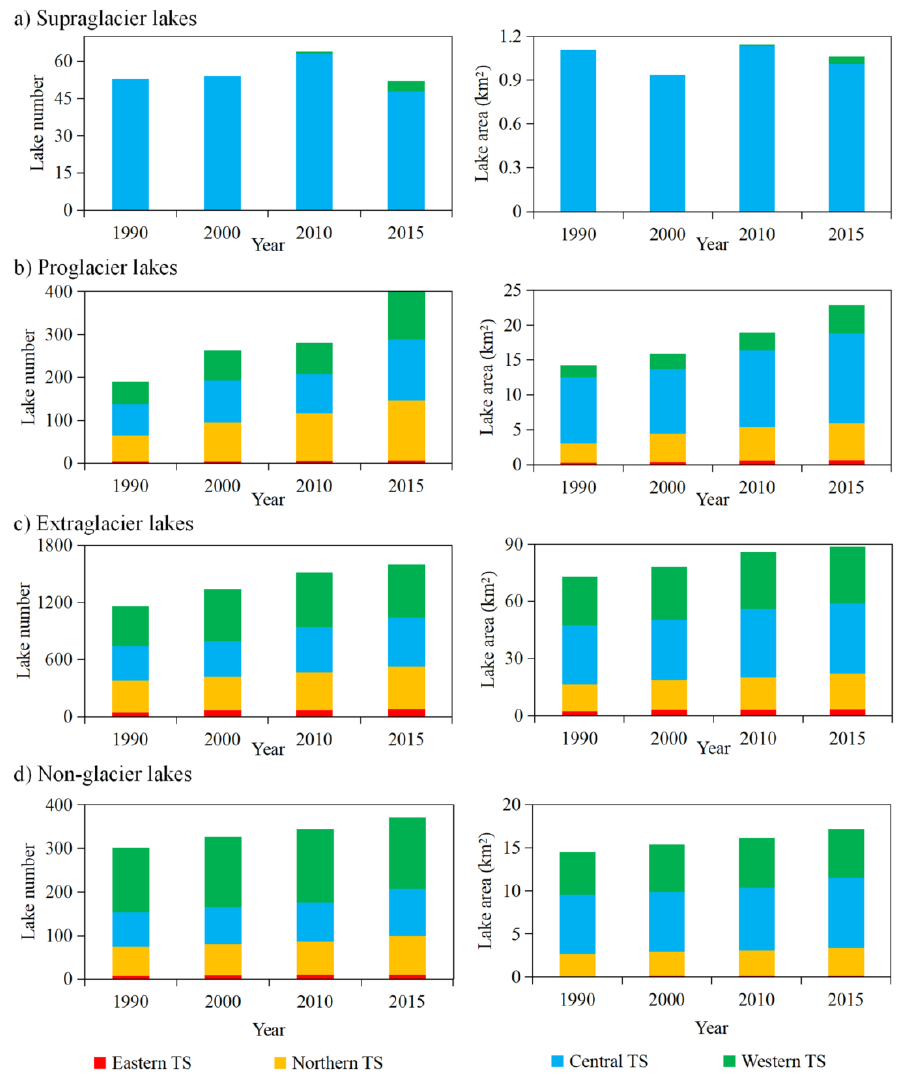
Figure 6. Variations in the number and area of the four types of alpine lakes in the TS between 1990 and 2015.